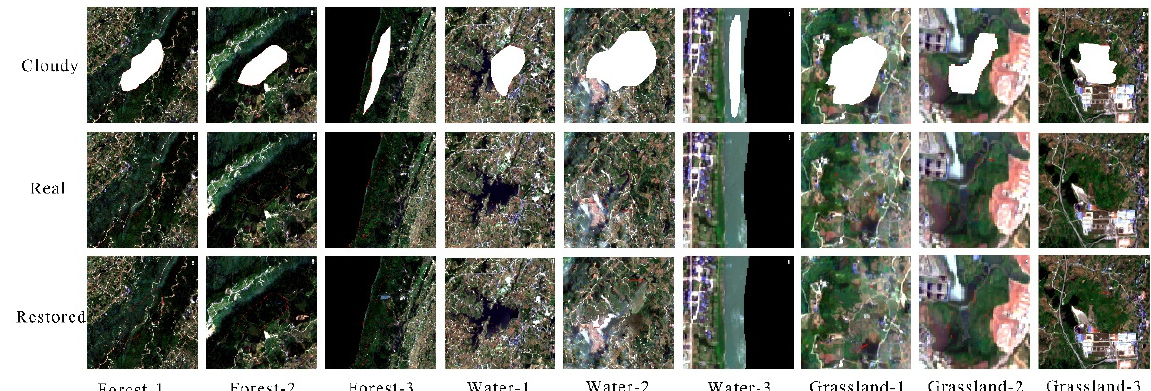
Figure 6. The red–green–blue composite images of Sentinel-2 image that were acquired on 26 April 2020. Three plots were selected for each land type. The cloud images in the first row are cloudy images simulated based on the real images in the second row. The third row is images recovered by the MNSPI approach. The white area represents the simulated thick cloud patch, and the red line is the cloud patch boundary.